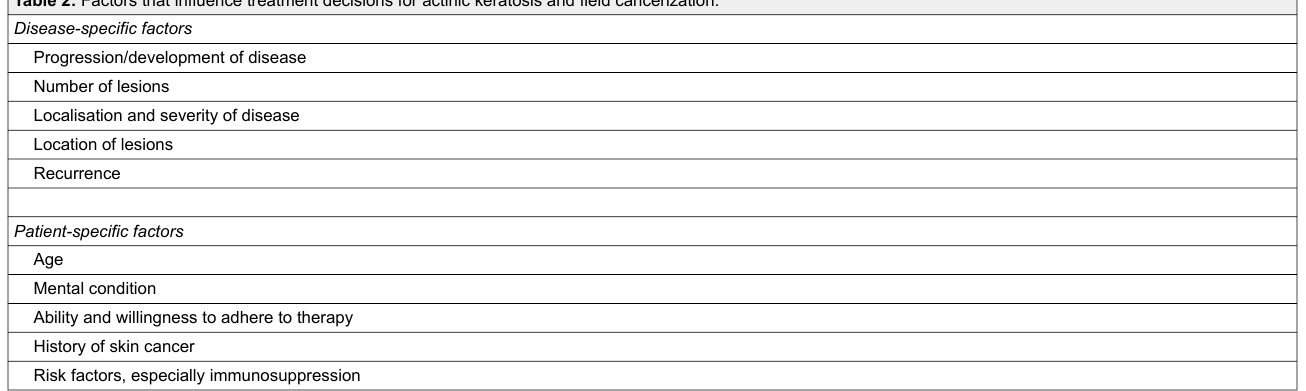
Table 2: Factors that influence treatment decisions for actinic keratosis and field cancerization . Disease-specific factors Progression/development of disease Number of lesions Localisation and severity of disease Location of lesions Recurrence Patient-specific factors Age Mental condition Ability and willingness to adhere to therapy History of skin cancer Risk factors, especially